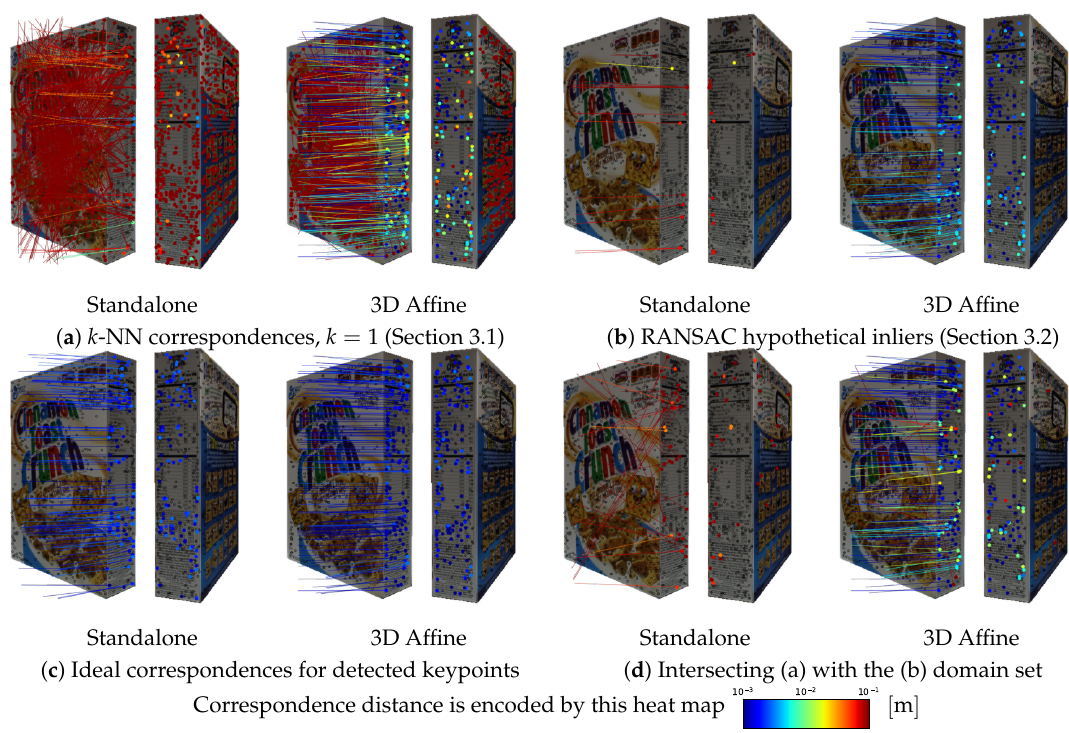
Figure 10. The standalone SURF [20] detector and SIFT [19] descriptor had difficulty detecting sufficient repeatable keypoints (left sides of a , b , and c ) and computing distinct descriptions (left sides of a , b , and d ), respectively, under relatively-large viewpoint change. The proposed embedding (3D affine) alleviated the problem by leveraging the geometric information from the depth maps to undo the viewpoint change effects (right side of b , refer to Section 5.1.1 for details). Correspondences are visualized as a sparse optical-flow to improve